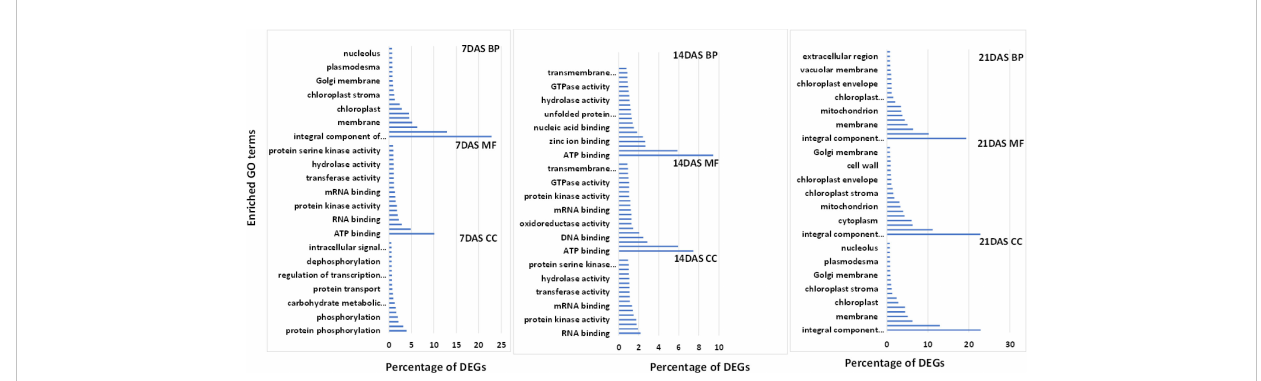
FIGURE 4 Top 20 enriched GO terms for the common DEGs in sugar maple leaf samples imposed to different drought stress periods (7, 14, and 21 days of drought stress). BP: biological process, CC: cellular component, and MF: molecular